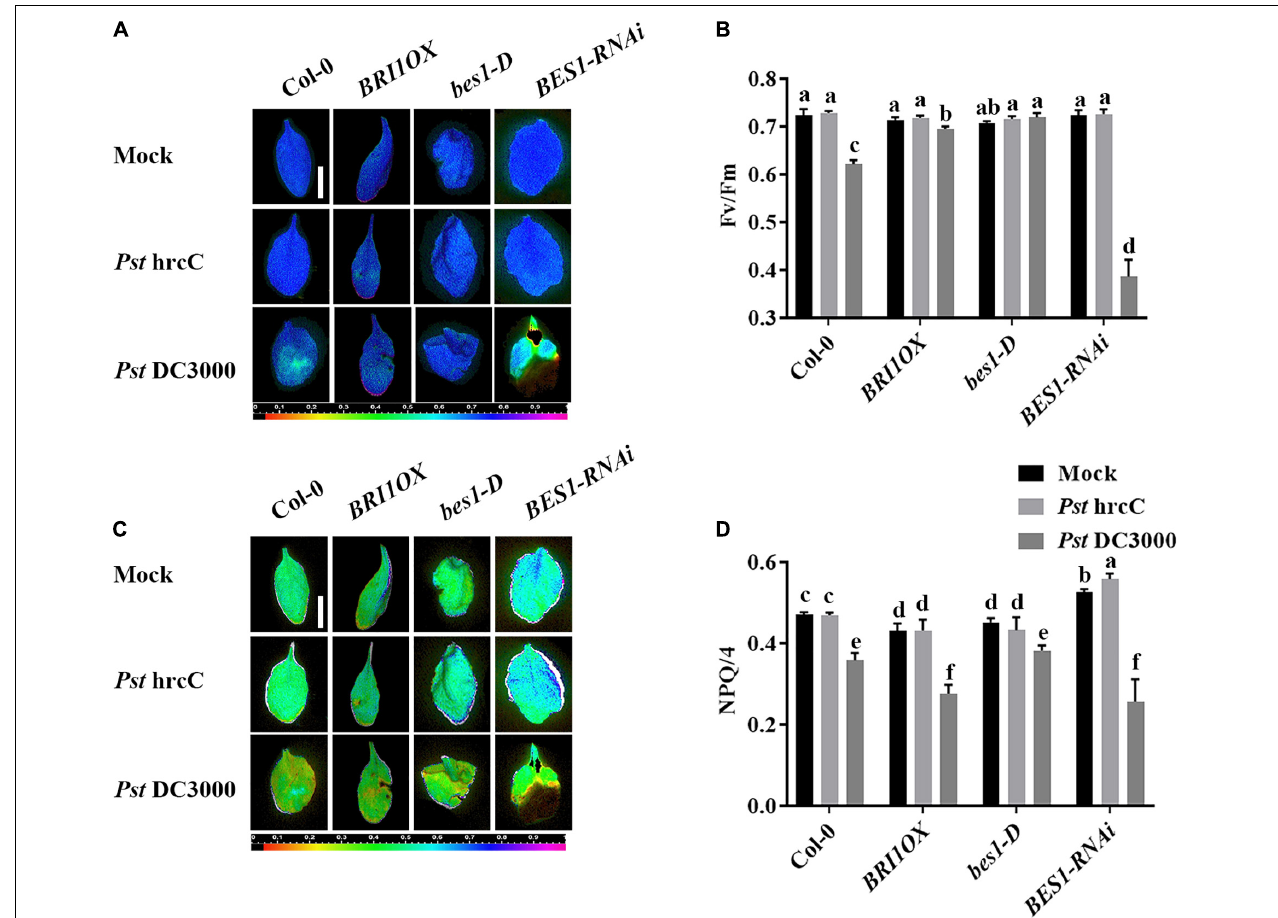
FIGURE 6 | Brassinosteroid signaling enhances plant defense by alleviating photosystem damage. Images of the maximum PSII quantum yield ( F v/ F m) (A) and NPQ/4 (C) in the leaves infected by Pst DC3000 or Pst hrcC at 3 dpi. Bar, 1.00 cm. Average values of F v/ F m (B) and NPQ/4 (D) for the respective chlorophyll fluorescence images. F v/ F m or NPQ/4 measured from 8 to 10 leaves and three biological repeats. Significant differences ( P < 0.05) are denoted by different lowercase